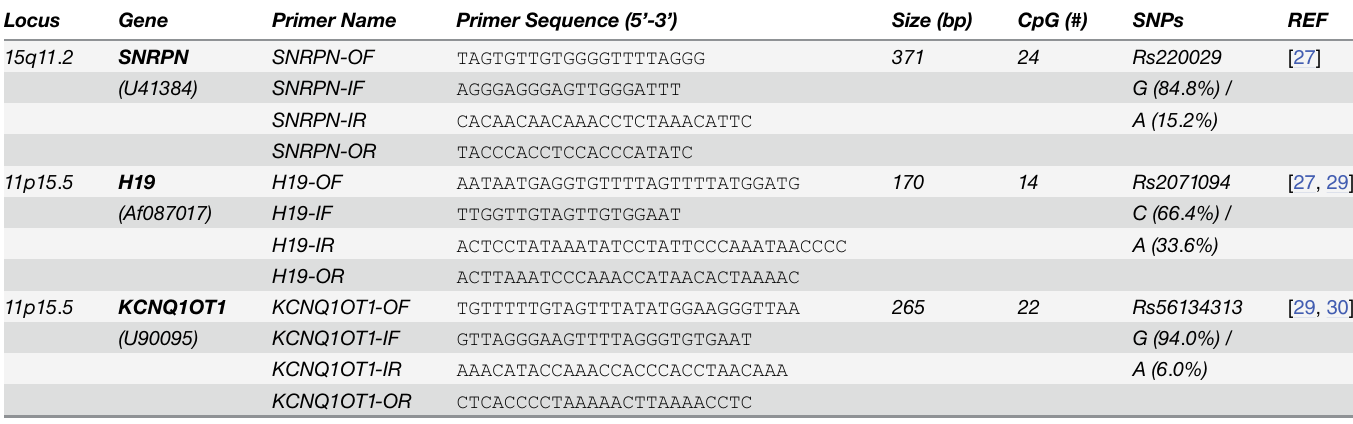
Table 2. PCR primers and parameters for bisulfite mutagenesis. Locus